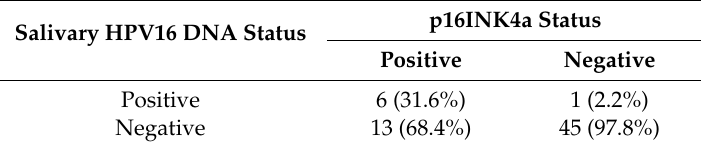
Table 4. Oral HPV16 infection and tumour p16INK4a in OC patients.